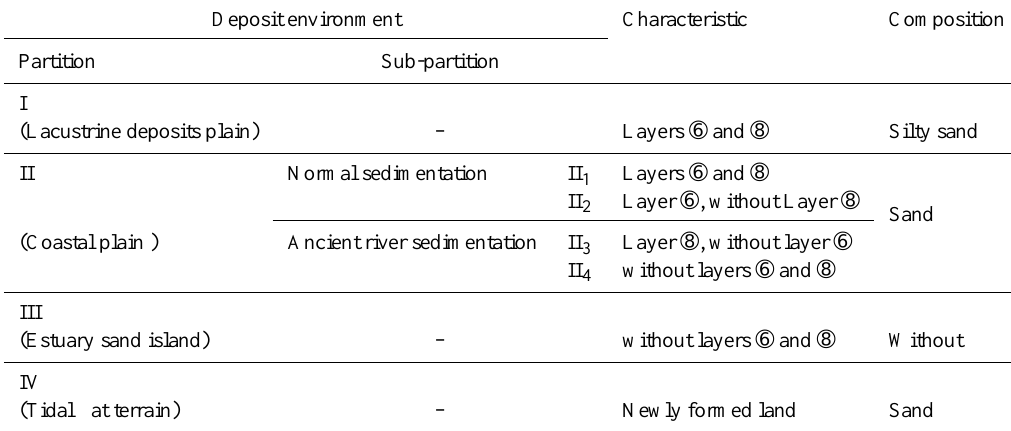
Table 2. Geological partition for strata combination.